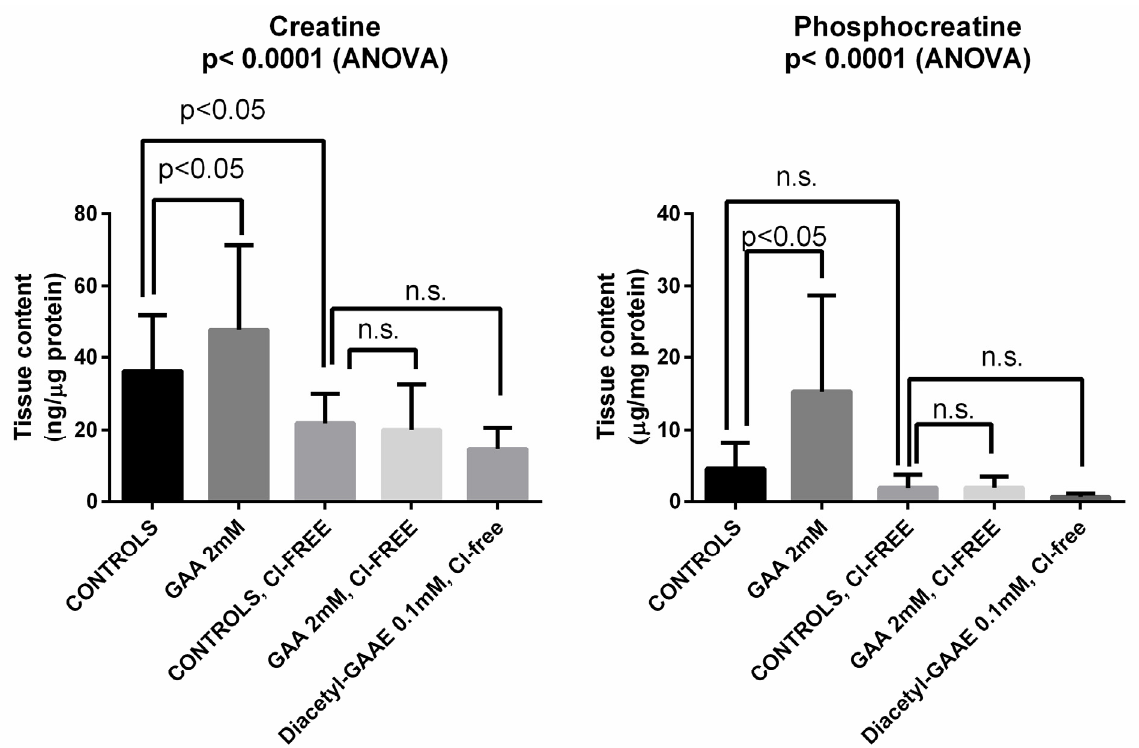
Figure 7. Incubation of brain slices with guanidine acetic acid (GAA) caused increase in brain slices’ content of creatine and phosphocreatine (compare first two columns in each graph). Such changes were statistically significant. Blocking the creatine transporter (which GAA also uses to enter cells [24]) by incubation with chloride-free medium caused a decrease in both compounds (compare first and third column in each graph), which was significant only for creatine. Furthermore, blocking the creatine transporter with Cl-free medium prevented the changes in creatine and phosphocreatine induced by GAA (compare third and fourth column in each graph). Diacetyl-GAAE, too, was unable to increase creatine and phosphocreatine after transporter block with Cl-free medium (compare third and fifth column in each graph). Statistics shown are for analysis of variance (ANOVA) or for Bonferroni’s multiple comparisons test; n.s. = not significant.